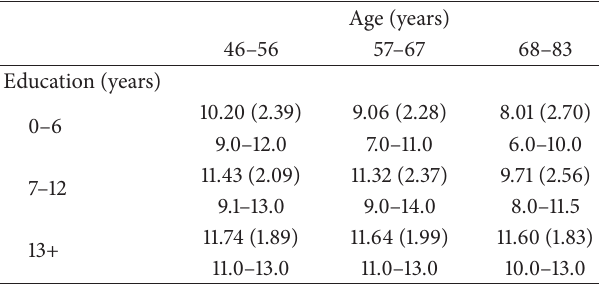
Table 2: Means (SD) and interquartile range of CIG total score as a function of age and education in the community